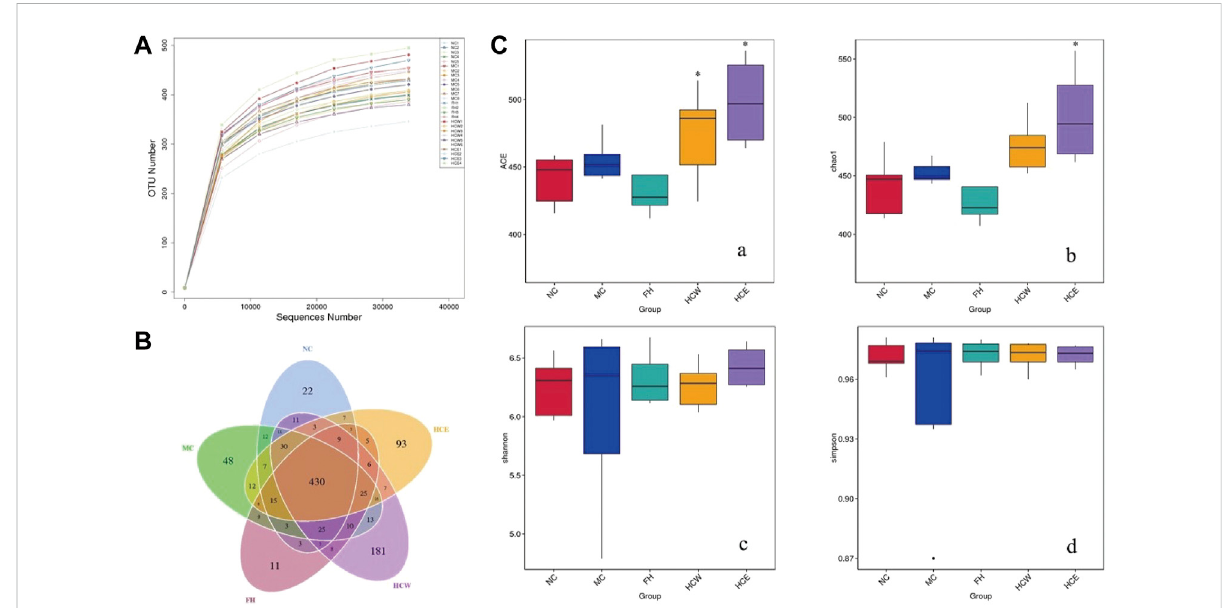
Re fl ectance curve (A) and Venn diagram (B) of intestinal microbial OTUs from HCW and HCE-treated CUMS mice and controls, (C) the alpha diversity of the ACE, Chao 1, Shannon and Simpson index of intestinal micro fl ora. Data are reported as mean ± SD. For statistical signi fi cant, * p < 0.05 compared with the model control group. NC, normal group; MC, model group; FH, Fluoxetine hydrochloride group; HCW, water extract of fl owers; HCE, 80% ethanol extract of fl